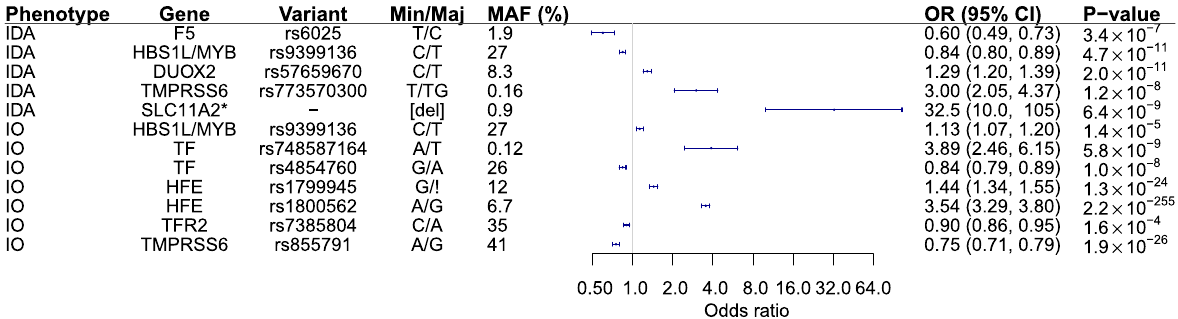
Fig. 5 Iron homeostasis variants associated with iron de fi ciency anemia (IDA) or iron overload (IO). A forest plot showing the odds ratio (error bars showing 95% con fi dence intervals) for each of the genetic variants associated with either iron de fi ciency anemia (IDA) or iron overload (IO). *Results for the SLC11A2 deletion variant are shown for the recessive model while results for other variants are for the additive model. Min/Maj minor/major allele, MAF minor allele frequency, OR odds ratio, CI con fi dence